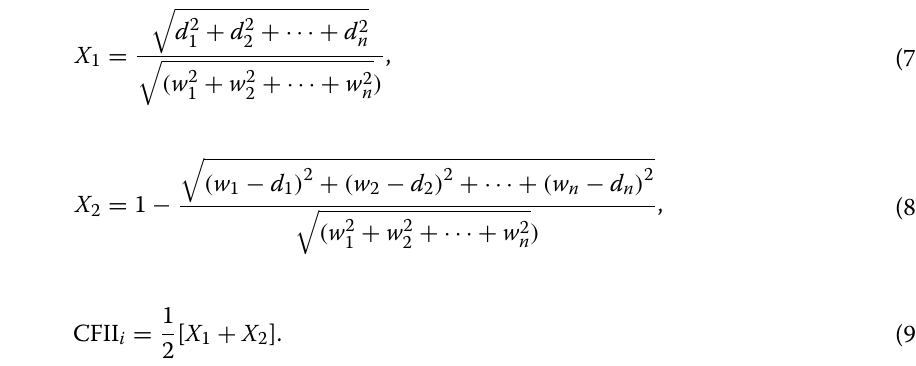
Table 2 Determinants of financial inclusion (fixed effect estimation)